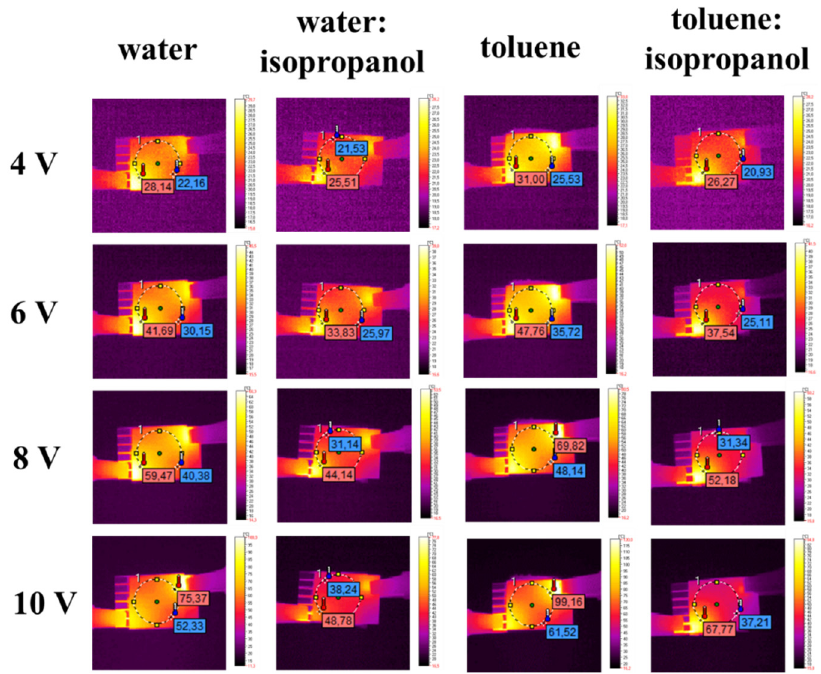
Figure 8. IR images obtained for device architectures (from left to right): Figure8. IRimagesobtainedfordevicearchitectures(fromlefttoright): ITO / PEDOT:PSS(water) / Ag / ITO, ITO/PEDOT:PSS(water)/Ag/ITO, ITO/PEDOT:PSS(water:isopropanol)/Ag/ITO, ITO / PEDOT:PSS(water:isopropanol) / Ag / ITO, ITO/PEDOT:PSS(toluene)/Ag/ITO, and ITO/PEDOT:PSS(toluene:isopropanol)/Ag/ITO at 4.0 V, 6.0 V, 8.0 V, and 10.0 V.